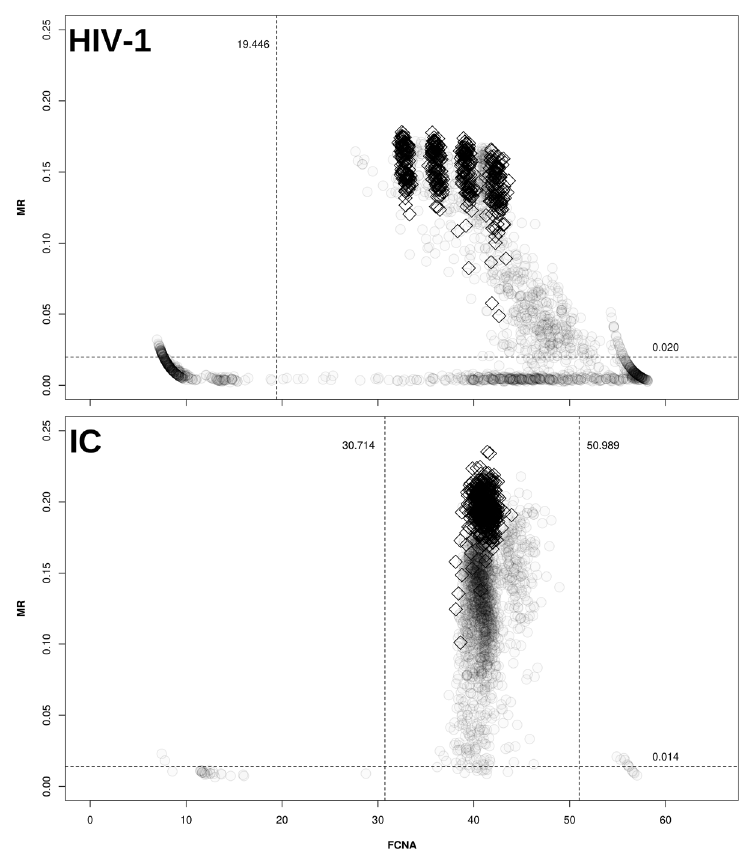
Figure 1. Cut-offs for maxRatio. Clinical samples ( ○ ) and CDs ( ◊ ) are plotted on the maxRatio plane; the numbers report the obtained cut-offs for MR (horizontal lines) and FCNA (vertical lines). Upper panel: MR/FCNA pairs for the HIV-1 target. To note how the CDs form four distinct clusters, corresponding to the different standard dilutions. Lower panel: MR/FCNA pairs for the IC target. To note that the data form a single cloud because the IC input was virtually the same for all reactions. The presence of two outlier groups at low and high FCNA values required to instantiate two